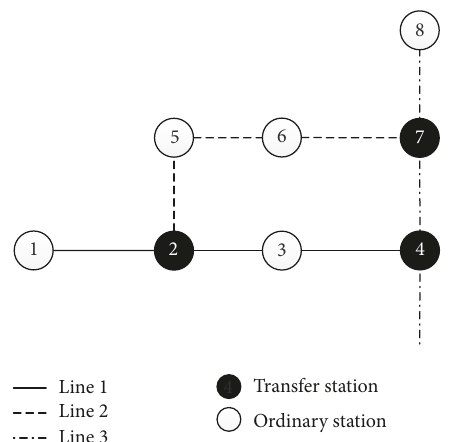
Figure6:Testednetworkforcomparativeanalysisoftraditionaland DUO approaches.